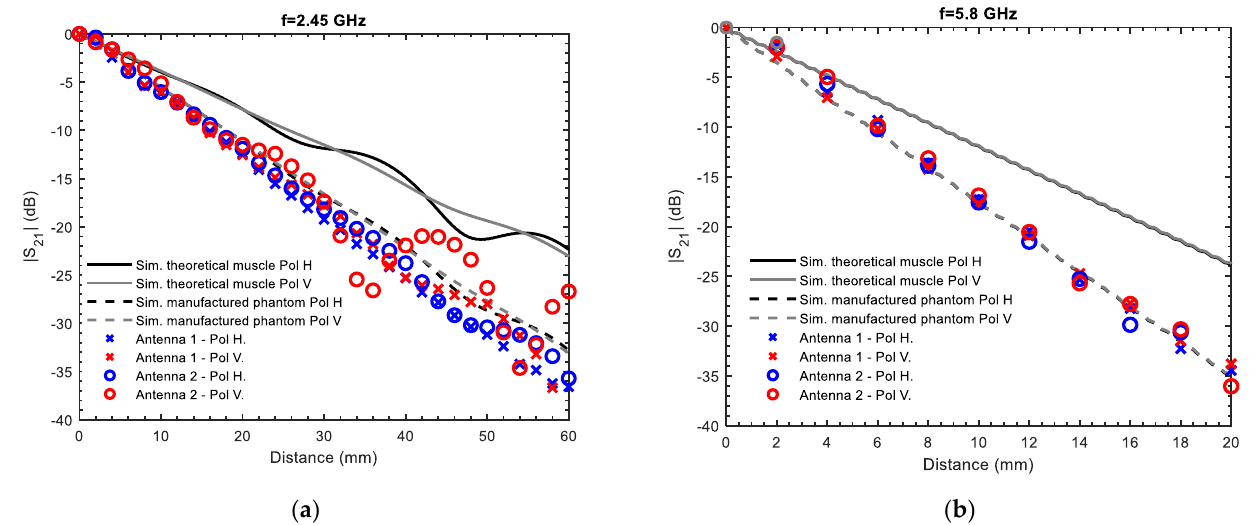
Figure 10. Normalized measurements vs. simulation (using theoretical and manufactured muscle dielectric properties). ( a ) f = 2.45 GHz and ( b ) f = 5.8 GHz.